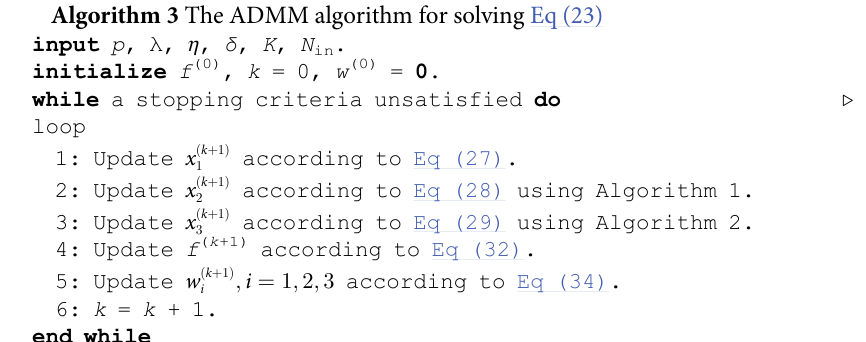
Algorithm 3 The ADMM algorithm for solving Eq